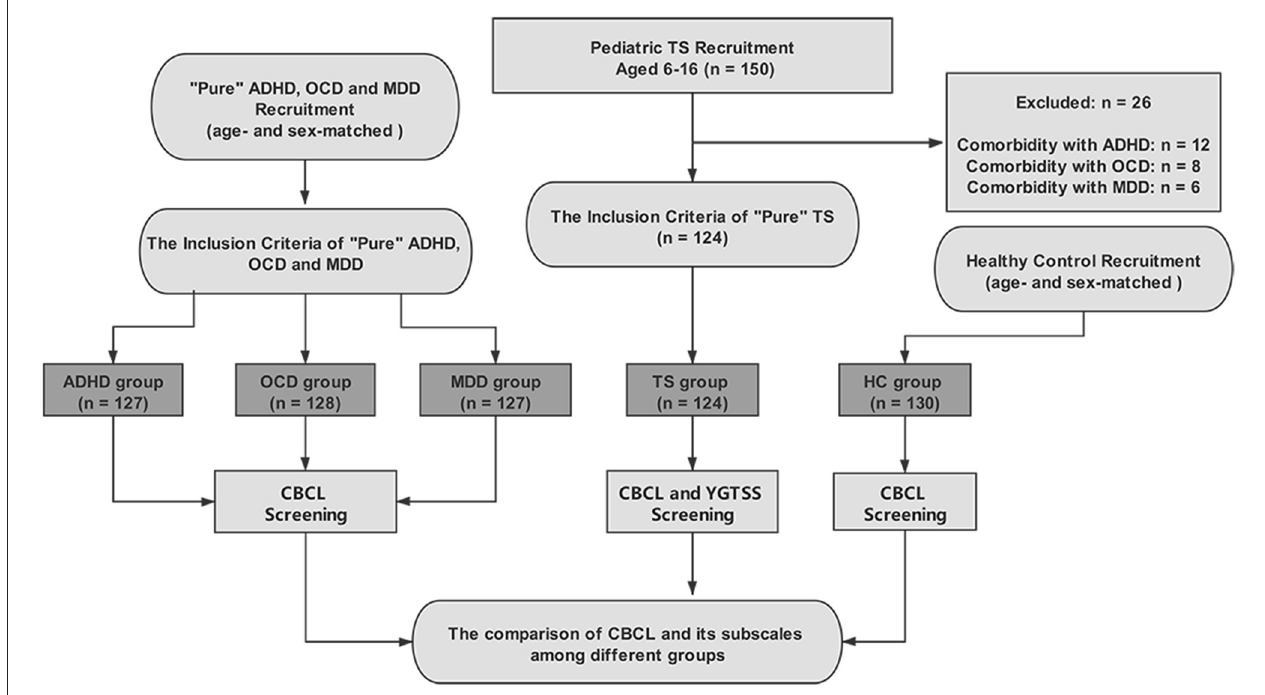
FIGURE 1 | Flowchart of the selection